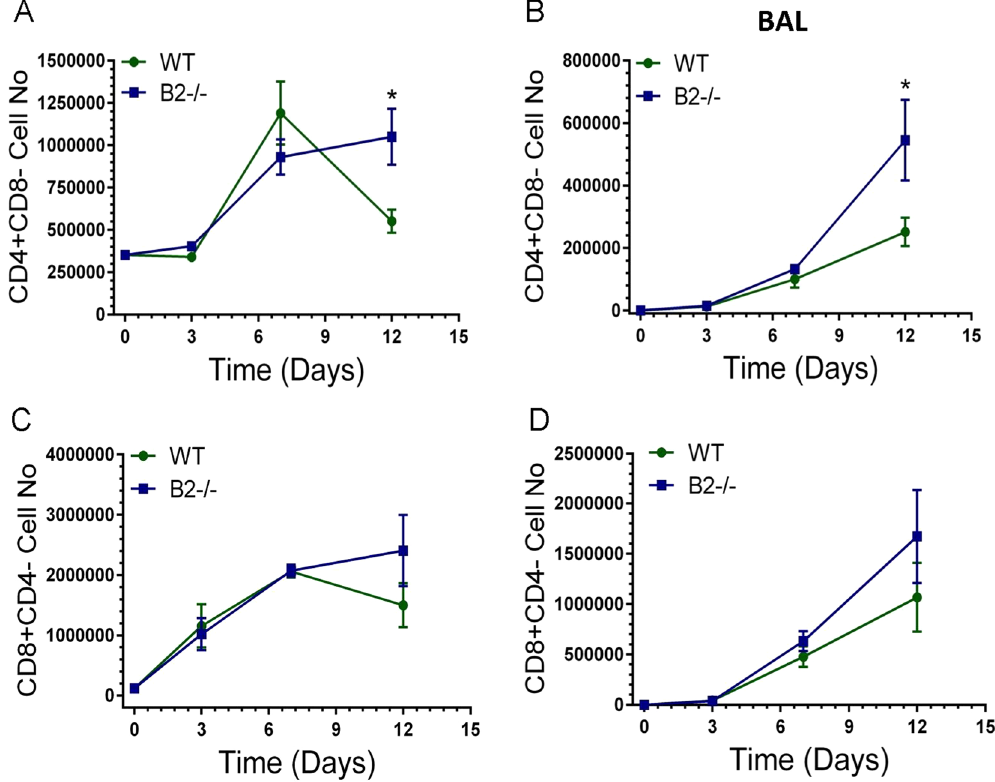
Figure 8. Endophilin B2 curtails contraction of CD4 + T lymphocytes recruited in lungs and BAL after IAV infection. The number of CD4 + CD8- and CD8 + CD4 + lymphocytes in lung ( A,C ) and BAL ( B,D ), at t = 0, 3, and 7, and n = 12 at t = 12. The data on day 12 are pooled from three independent